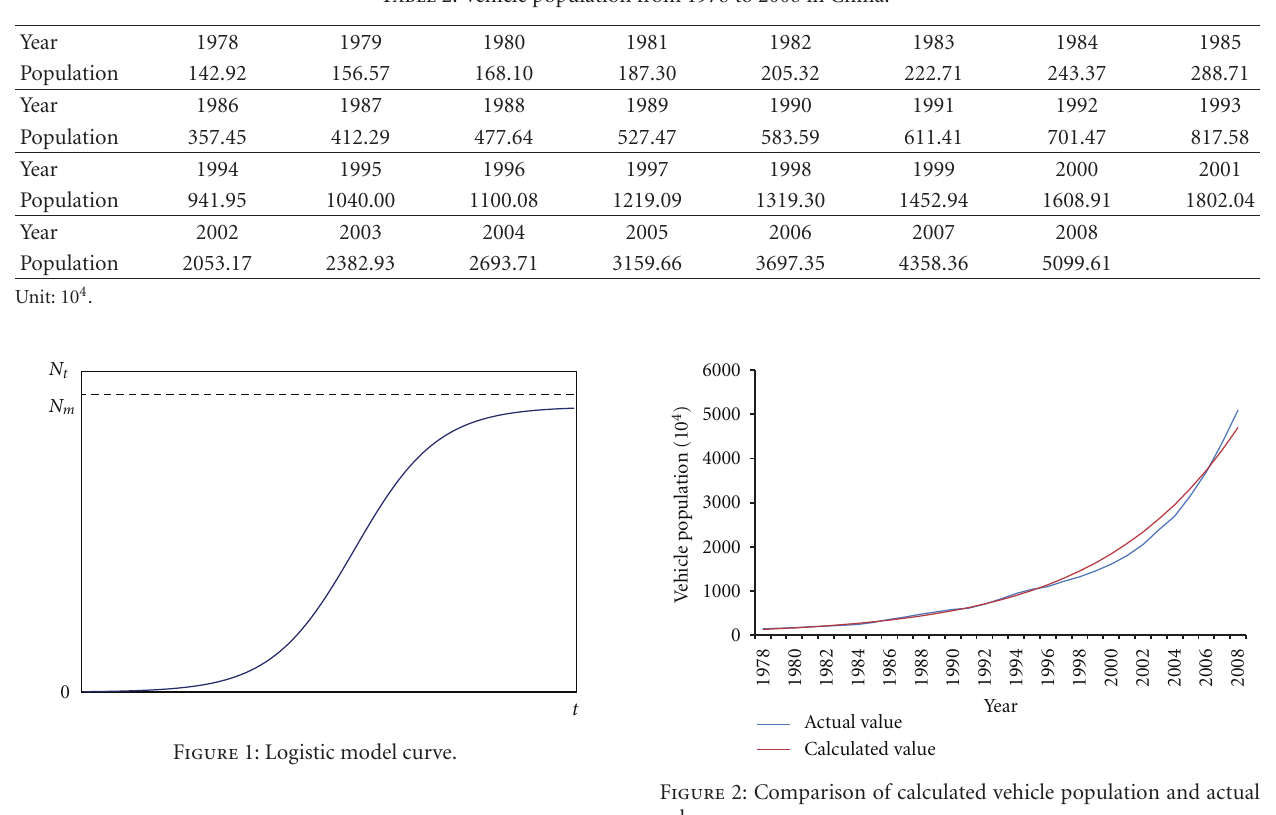
Table 2: Vehicle population from 1978 to 2008 in China.